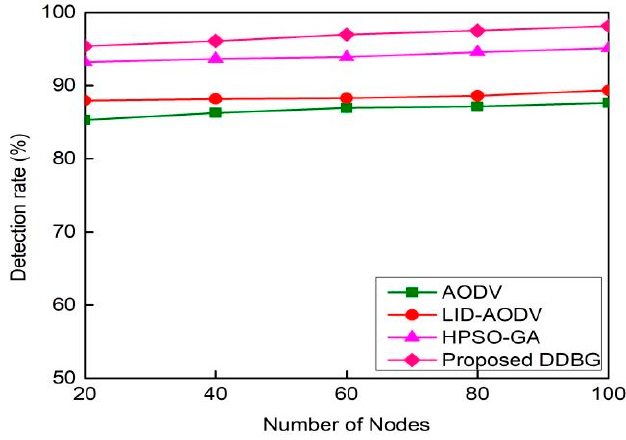
Figure 4. The detection rate (%).